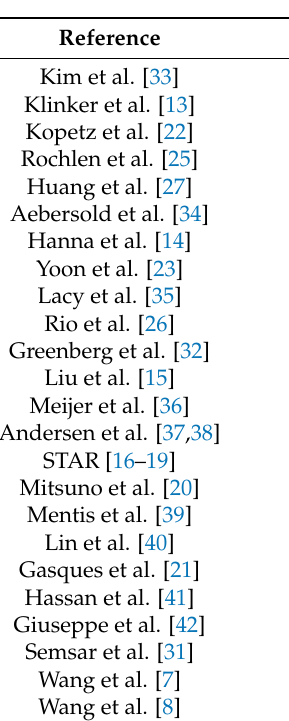
Table 1. Post-2015 Remote Collaboration and Telementoring